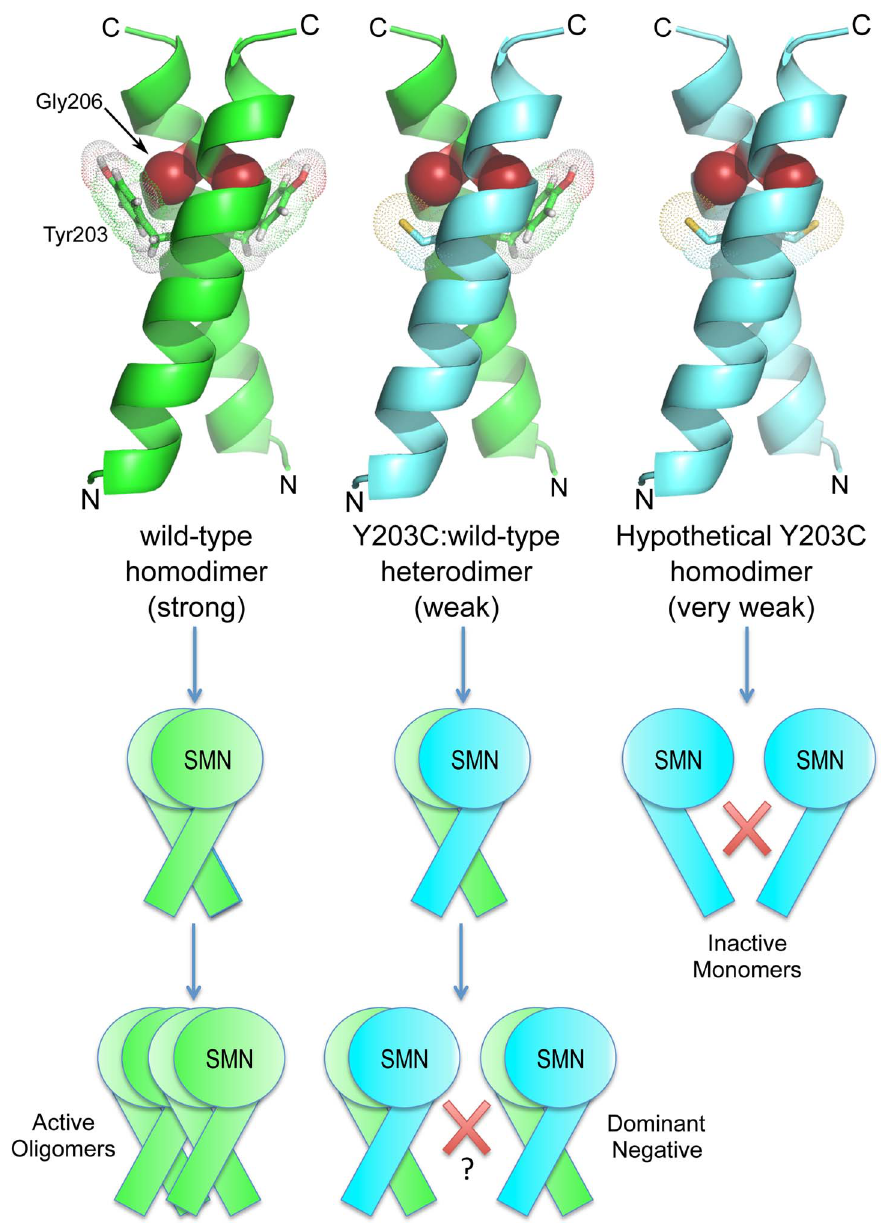
Figure 7. SMN Y203C is predicted to disrupt an intermolecular Y-G contact, weakening or preventing oligomerization. A combination of experimental analysis and structural modeling of Drosophila SMN dimers reveals that wild-type homodimers (left column) can make two Y-G contacts and are able to form higher-order structures (active SMN oligomers). In contrast, Y203C homodimers (right) are unable to make these contacts and do not dimerize (inactive SMN monomers). Interestingly, Y203C:WT heterodimers (middle) make only one Y-G contact but the loss of one interaction does not prevent dimerization. These findings suggest that the dominant negative activity of Y203C is due to an inability of the heterodimers to form active, higher-order